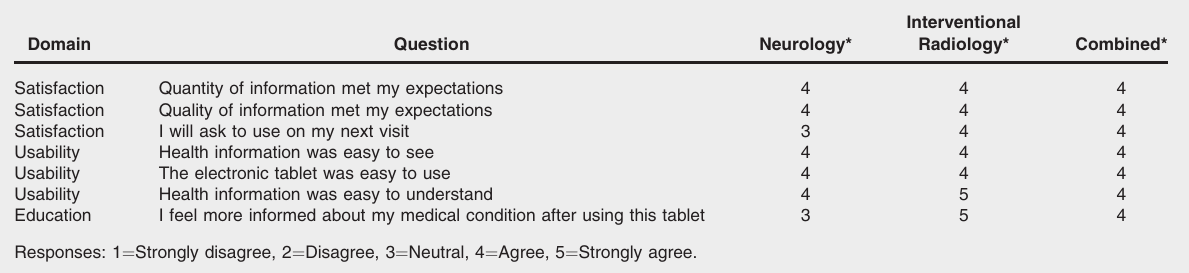
Measures (median) of satisfaction, usability, and